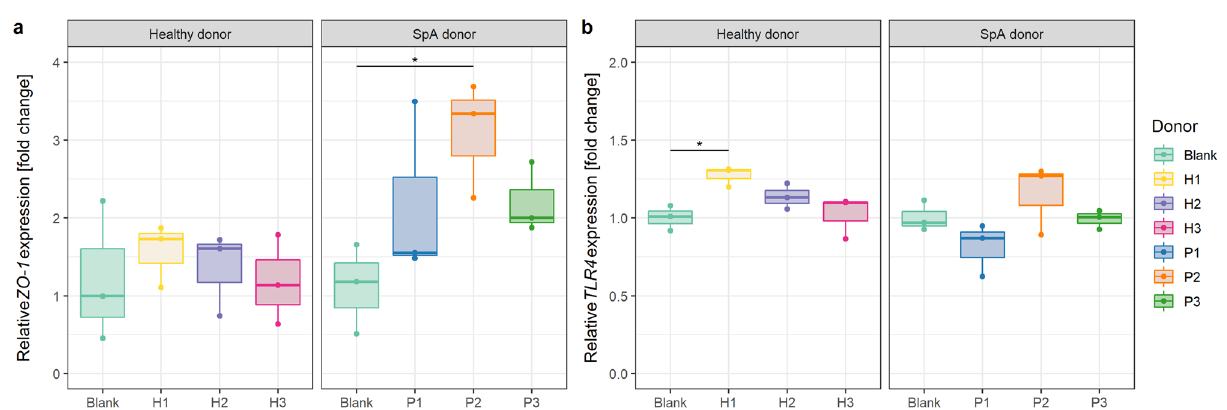
Figure 6. Relative mRNA expression of ( a ) ZO-1 and ( b ) TLR4 in triple cocultures exposed to fecal microbiota compared to blank triple cocultures (not exposed to microbiota) (n = 3). *p <